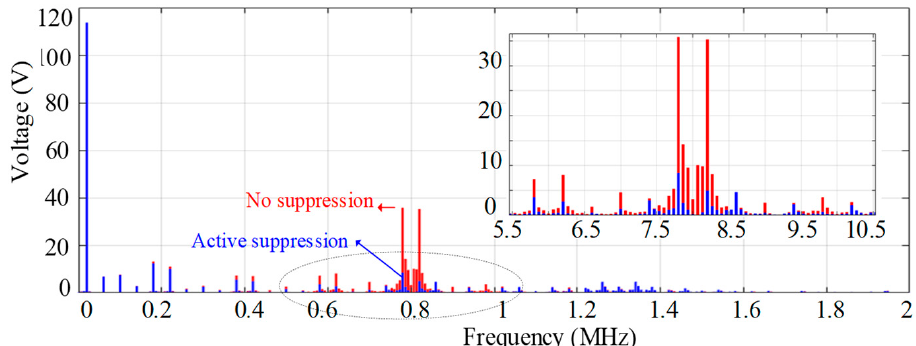
from 35 V to 8 V when the SHE PS method was utilized.